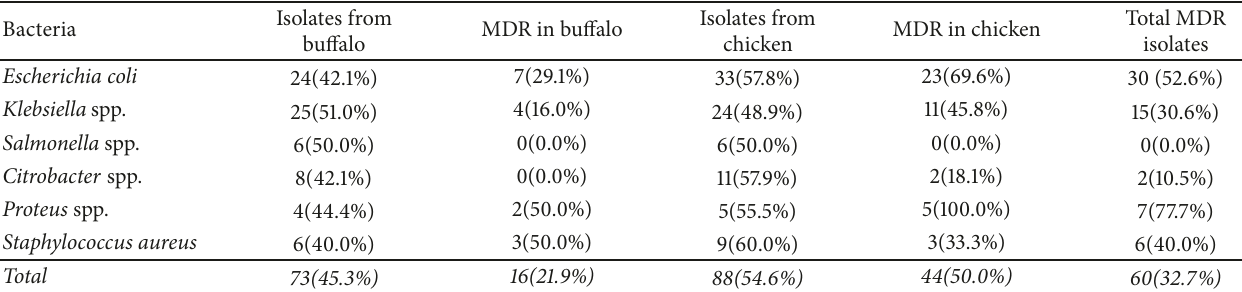
Table 4: Multidrug-resistant bacterial isolates from buffalo and chicken